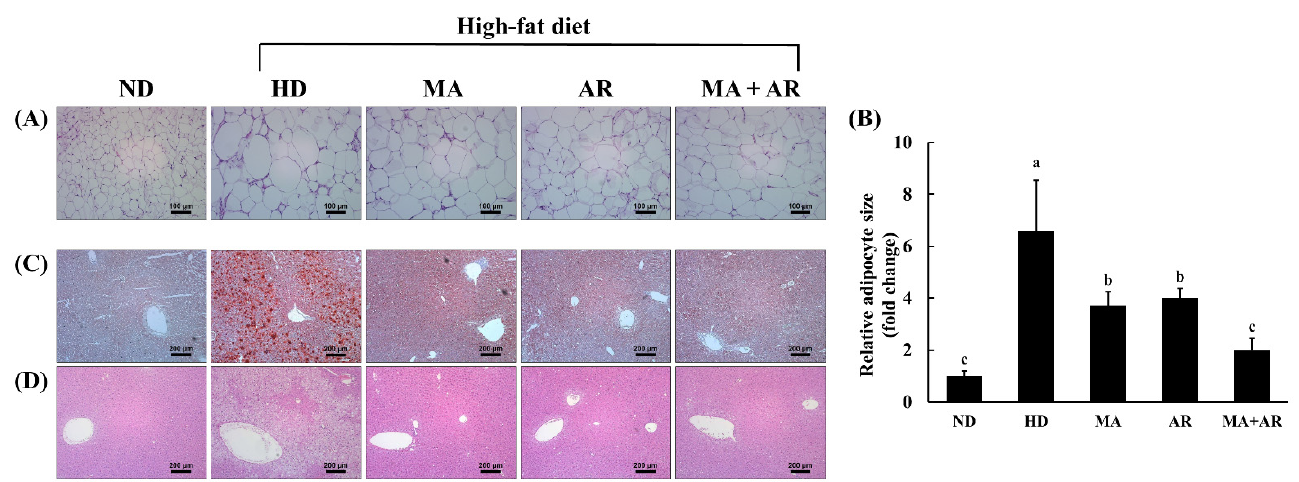
Figure 4. Histology of epididymal white adipose tissue (WAT) and liver in the experimental mice. ( A ) WAT section ( × 100) by H&E staining, ( B ) adipocyte size of WAT, ( C ) liver section ( × 200) by ORO staining, ( D ) liver section ( × 200) by H&E staining. ND, normal diet, HD, high-fat diet, MA, high-fat diet + M. alba 400 mg/kg bw, AR, high-fat diet + A. melanocarpa 400 mg/kg bw, MA+AR, high-fat diet + mixture of M. alba and A. melanocarpa (400 mg/kg bw). Results are expressed as means ± S.D ( n = 10). Means with different superscript letters (a, b, c) are significantly different from each other by Duncan’s test of ANOVA at p < 0.05. “a” denotes the highest value and “c” represents the lowest value.